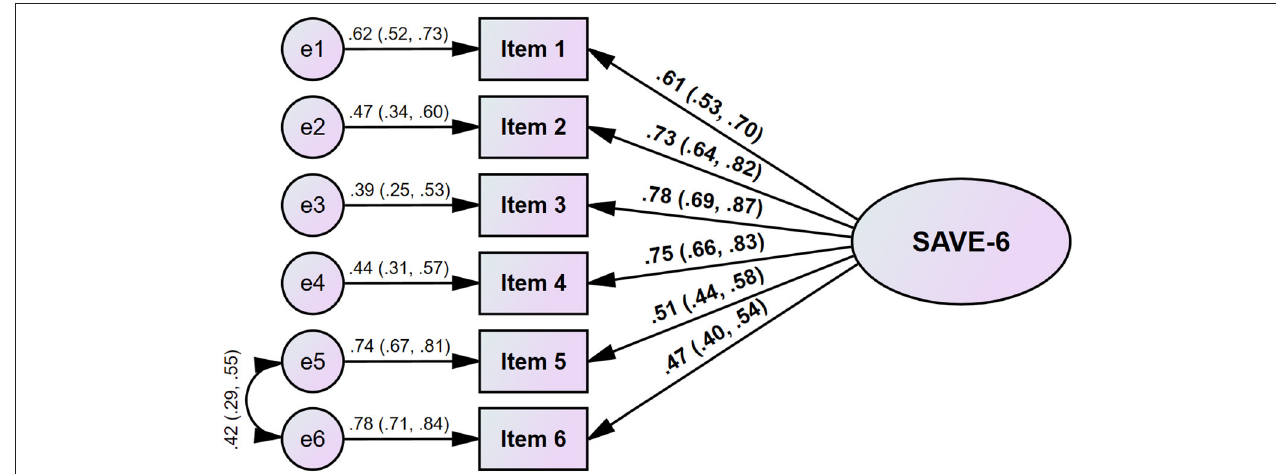
FIGURE 1 | Factor structure of the SAVE-6 among cancer